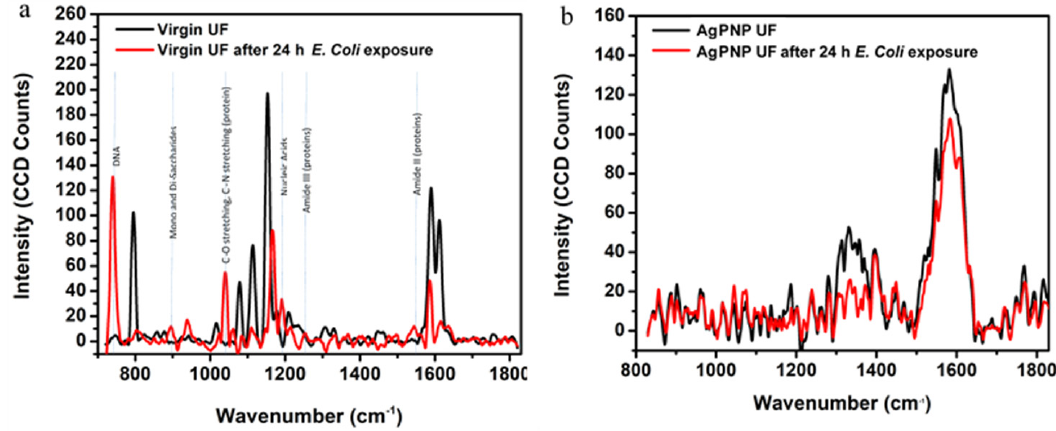
Figure 13. Raman spectra of membrane surface after 24 h exposure to E. coli for virgin ( a ) and 5 AgPNP-BL UF ( b ) membranes.